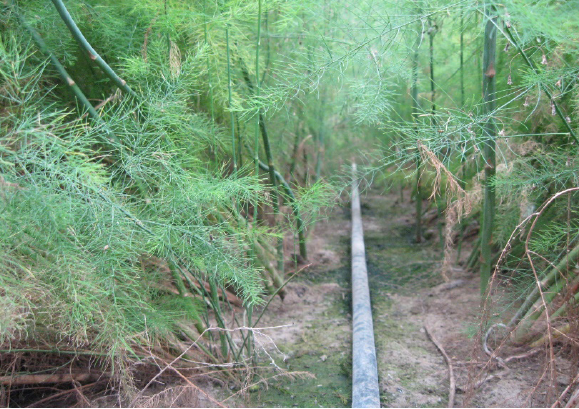
Figure 4. Number of Prodiplosis longfila Gagné adults in sticky surface panel traps throughout the year (2014 and 2015).